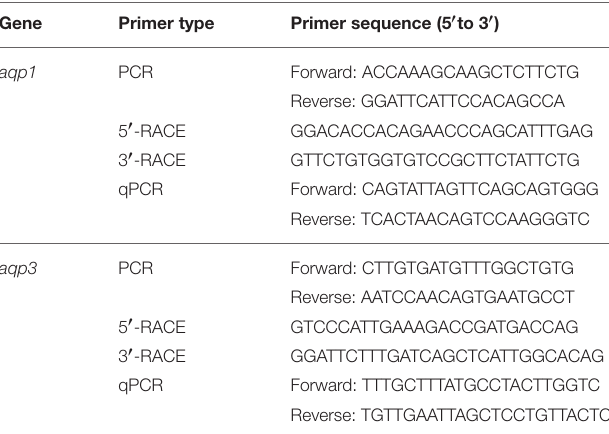
TABLE 1 | Primers used for PCR, RACE, and qPCR of aquaporin 1 ( aqp1 ) and aquaporin 3 ( aqp3 ) from the gills of Protopterus annectens